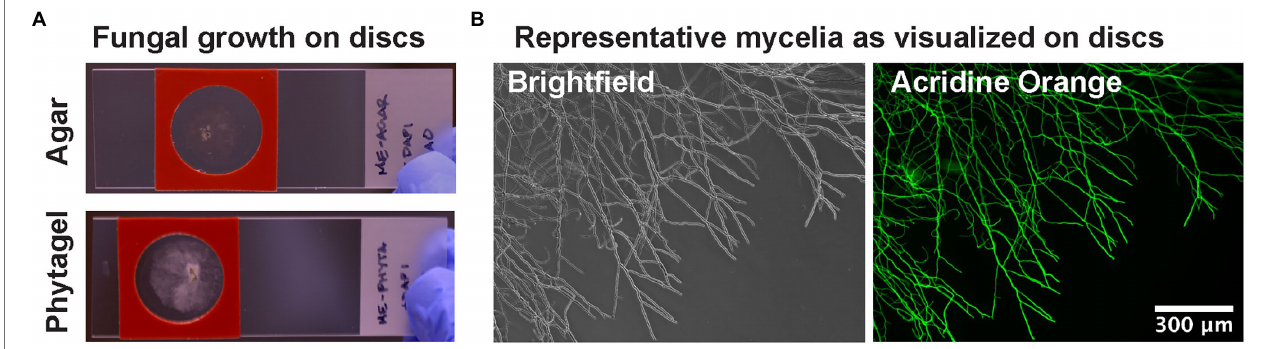
FIGURE 1 | Hydrogel discs for culturing filamentous fungi on slides. (A) Discs are molded to be approximately the thickness of a glass coverslip and are suitable for culturing with a reagent barrier for solution exchange in FISH staining methods. (B) Example brightfield and fluorescence microscopy images of fungal mycelia grown on